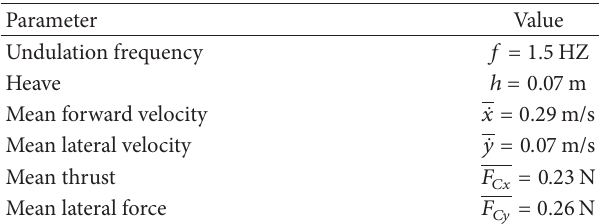
Table 2: Swimming parameters of UC-Ika